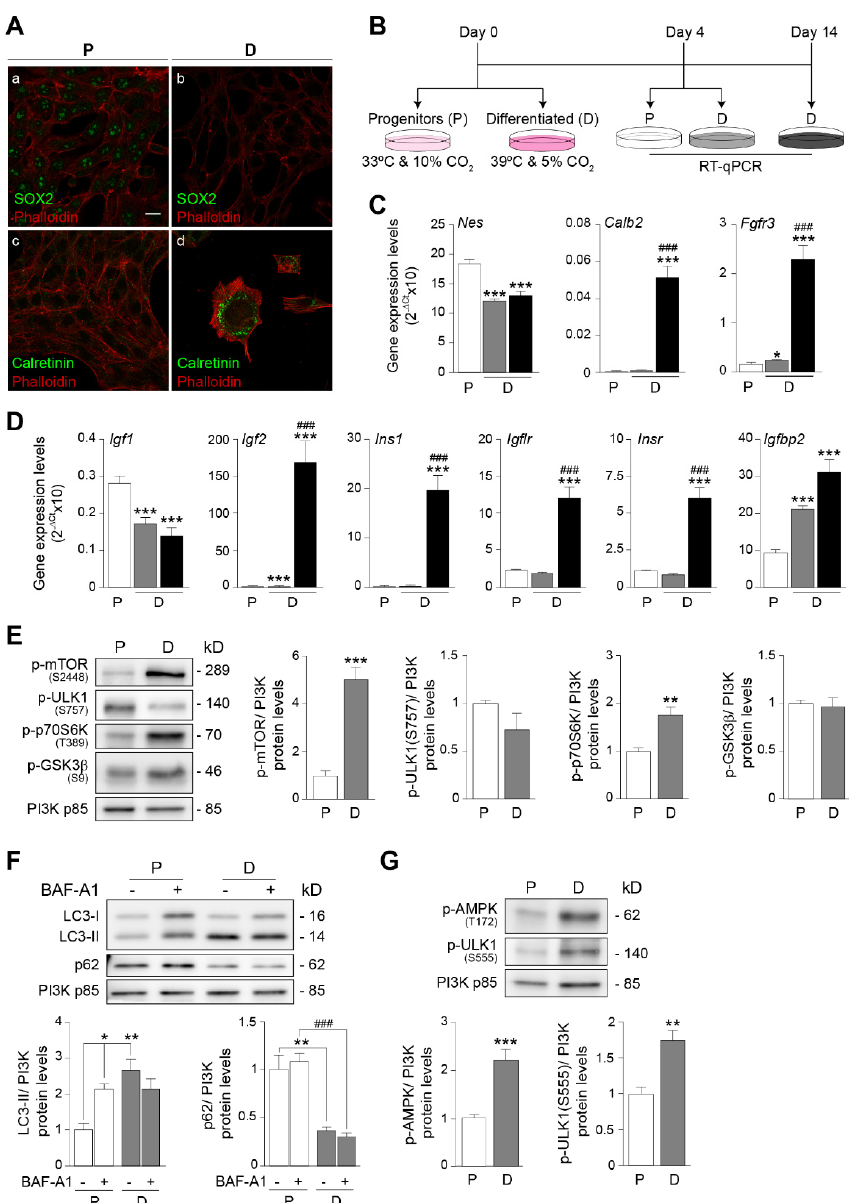
Figure 2. Progenitor and differentiated HEI − OC1 auditory cells show distinct metabolic profiles de- pending on the differentiation stage. ( A ) Representative confocal images of HEI − OC1 progenitor (P) and differentiated ( D ) auditory cells immunolabeled for SOX2 ( a , b ) and calretinin ( c , d ), both in green. Cells were incubated at 33 °C and 10% CO 2 (HEI − OC1 P) or at 39 °C and 5% CO 2 (HEI − OC1 D) for 4 days. Cellular cytoskeleton was stained with Alexa Fluor ® 546 phalloidin. Scale bar = 20 µm. ( B ) HEI − OC1 P cells were cultured for 4 days under proliferative conditions, and HEI − OC1 D cells were cultured for 4 or 14 days under differentiation conditions. Cells were then lysed, and the ex- pression of target genes was analyzed by qPCR. ( C , D ) mRNA expression levels of Nes , Calb2 and Fgfr3 ( C ) and of Igf1 , Igf2 , Ins1 , Igf1r , Insr and Igfbp2 ( D ) were measured in HEI − OC1 P cultured for 4 days (white bars) and in HEI − OC1 D cells incubated for 4 (gray bars) or 14 (black bars) days. Gene expression levels were calculated as 2 −Δ Ct using Hprt1 as an endogenous housekeeping gene. Data are expressed as mean ± SEM from n = 3 − 11 independent samples measured in triplicate. Statistical significance was estimated by one-way ANOVA: * p < 0.05 and *** p < 0.001 versus HEI − OC1 P; ###